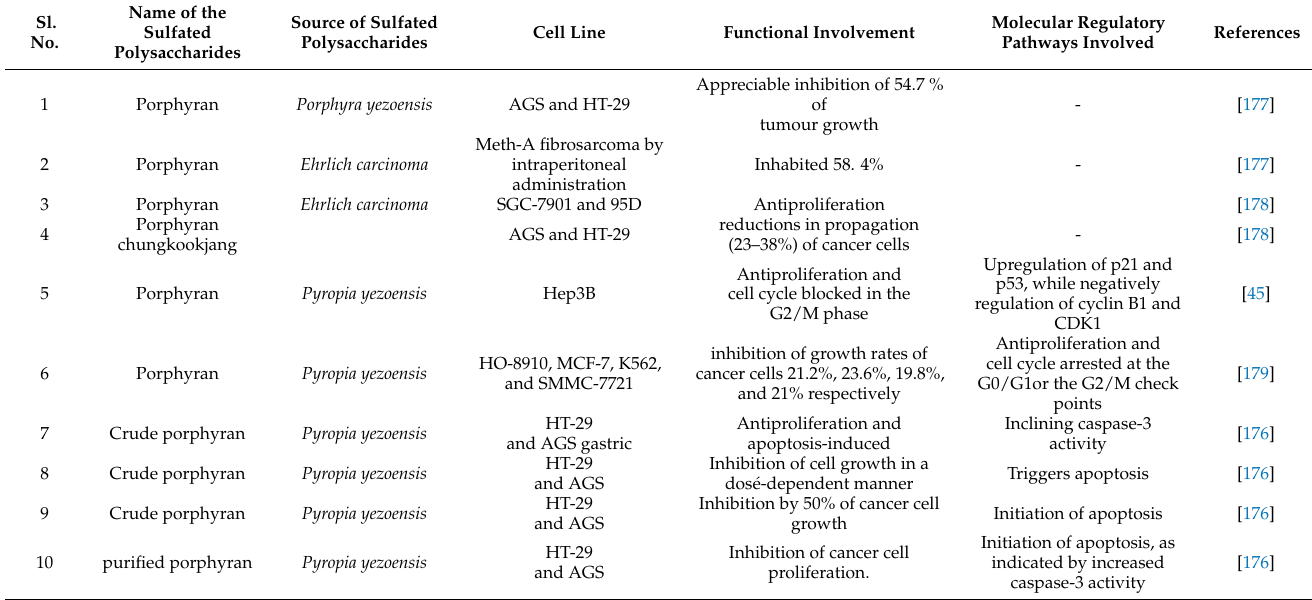
Figure 7. Sulfated polysaccharides displayed different chemopreventive roles in cancer. Sulfated polysaccharides such as ulvan, fucoidan, carrageenan, and porphyran displayed apoptosis in several cancer cell lines. Fucoidan, and carrageenan displayed potent antimetastatic effects in diverse cancer cell lines. Fucoidan, ulvan, and carrageenan displayed potent antiangiogenesis effects in different cancer cell lines. Moreover, fucoidan, carrageenan, and porphyran potential arrest cell cycles in cancer. Table 3. Sulfated polysaccharides from red algae and their apoptosis modulating in cancer therapeutics.